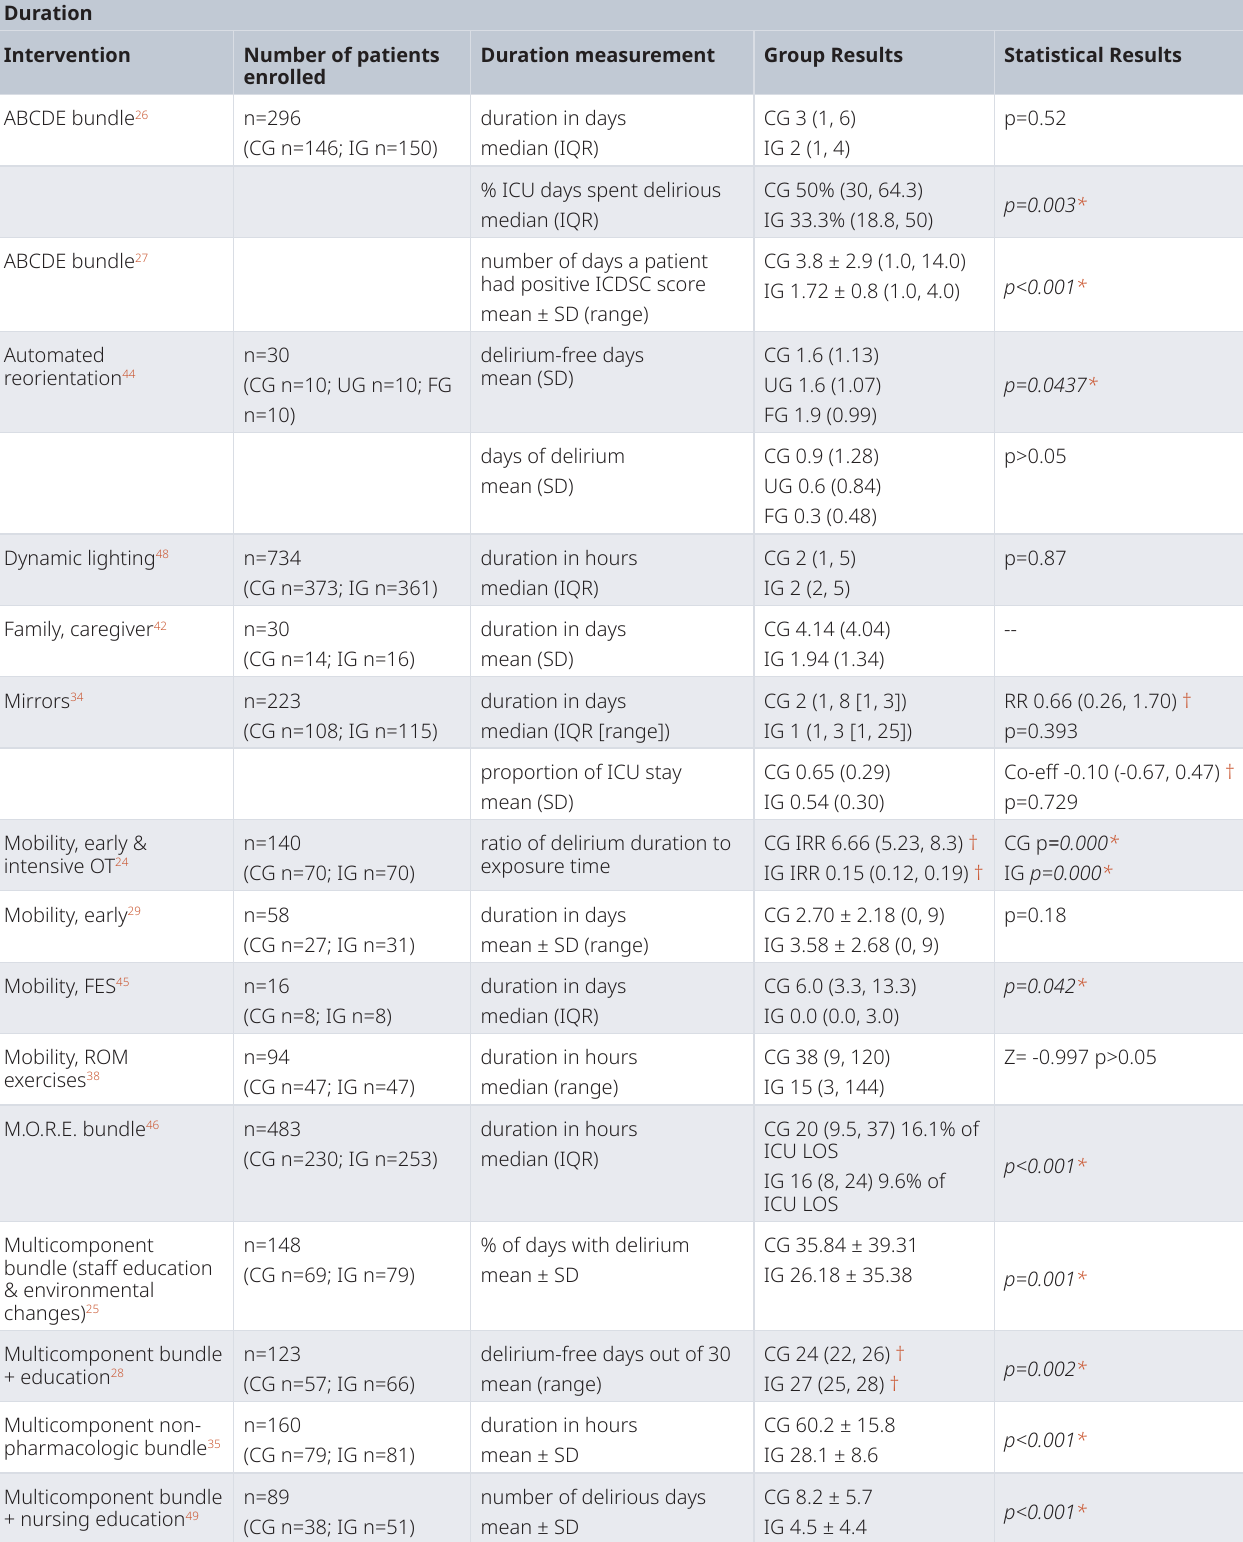
Table 4. Results on duration of